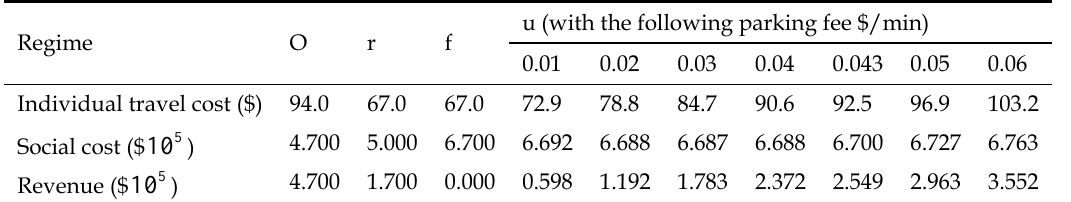
Table 1. Main numerical results in various regimes in the case of fixed demand Regime O r f